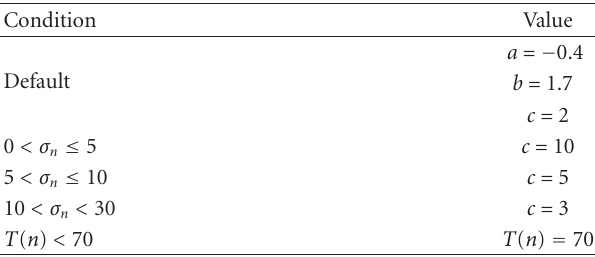
Table 1: Dynamic variation conditions for the threshold coe ffi -